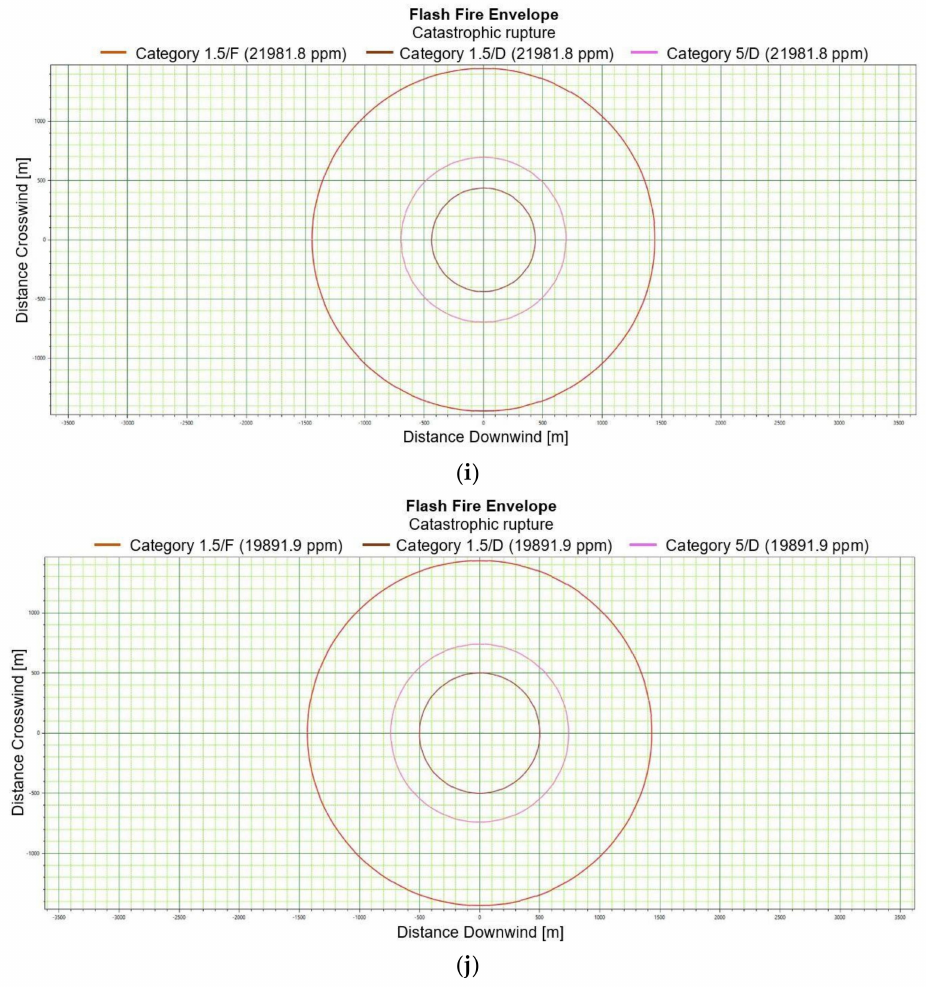
Figure 3. ( a ). Flash fire envelope—catastrophic rupture 1 m ASL, LNG-Light, winter. ( b ). Flash fire envelope—catastrophic rupture 1 m ASL, LNG-Light, summer. ( c ). Flash fire envelope—catastrophic rupture 1 m ASL, LNG-Heavy, winter. ( d ). Flash fire envelope—catastrophic rupture 1 m ASL, LNG-Heavy, summer. ( e ). Flash fire envelope—catastrophic rupture 2 m ASL, LNG-Light, winter. ( f ). Flash fire envelope—catastrophic rupture 2 m ASL, LNG-Light, summer. ( g ). Flash fire envelope— catastrophic rupture 5 m ASL, LNG-Light, winter. ( h ). Flash fire envelope—catastrophic rupture 5 m ASL, LNG-Light, summer. ( i ). Flash fire envelope—catastrophic rupture 0 m ASL, LNG-Light, winter. ( j ). Flash fire envelope—catastrophic rupture 0 m ASL, LNG-Heavy, summer. For LNG light winter and LNG light summer (1 m; 2 m; 5 m), the season of the